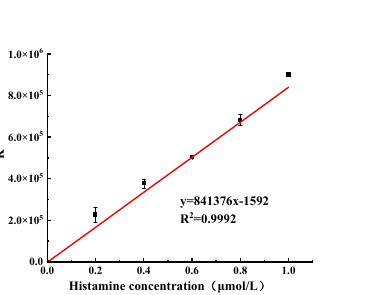
Figure 3. Fluorescence colorimetric dual-mode integrated value ( K ) and histamine concentration.